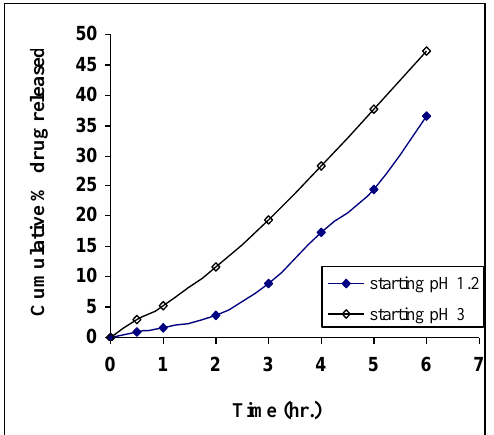
Figure(4): The effect of starting pH in the receptor solution on the release of naproxen from 1.0% (w/v) pectin